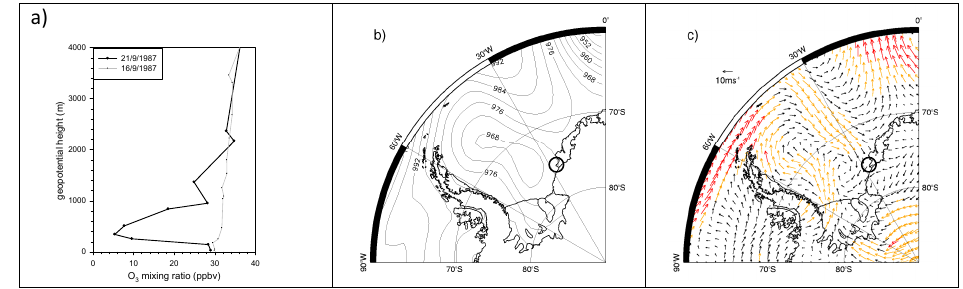
Fig. 12. (a) Ozonesonde measurements on 21 September 1987 compared with an un-depleted profile for the middle of the same month; (b) mean sea level pressure on 21 September 1987 (noon); (c) 10-m wind vectors on 21 September 1987 (noon) – wind speeds identified as: black = < 8ms − 1 ; orange = 8 to 12ms − 1 ; red = > 12ms − 1 . Halley is marked by the black circle on the plots.